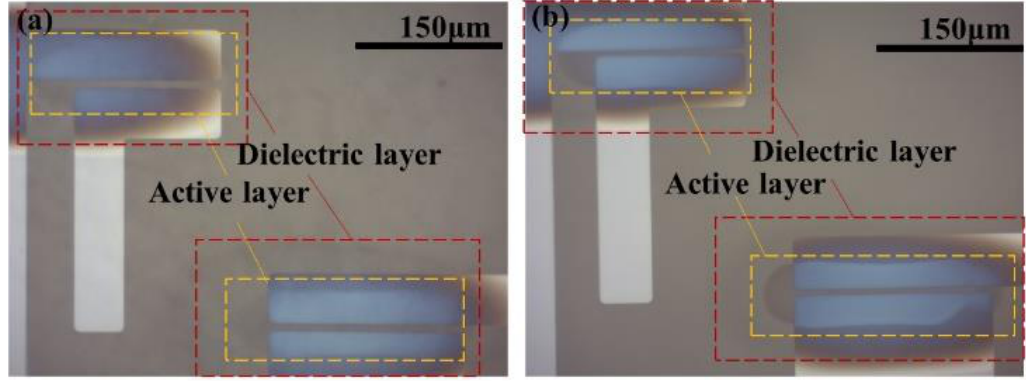
Figure 2. Polarizing microscope images of TFTs with ( a ) InGaO and ( b ) InGaSnO semiconductor layers.